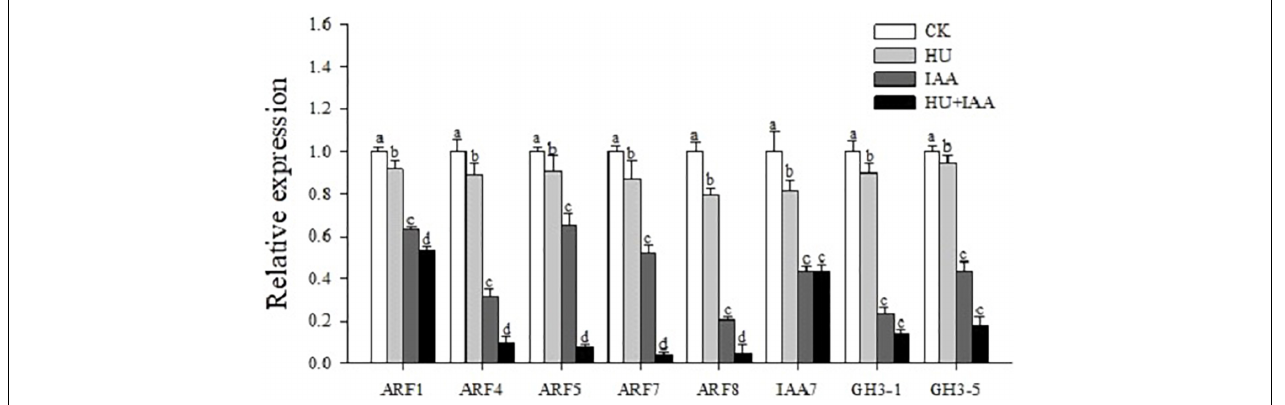
FIGURE 8 | Hormone-glucose conjugation (HU + IAA) negatively regulates the auxin signaling. Transcript analysis of the auxin signaling pathway genes in HU, IAA, and their combination treatment compared to the control. Different letters indicate significant differences between treatments, tested by one-way ANOVA followed by Fisher’s test ( n = 3, p < 0.05). CK, Control; HU, Hydroxyurea; IAA, indole-3-acetic acid.